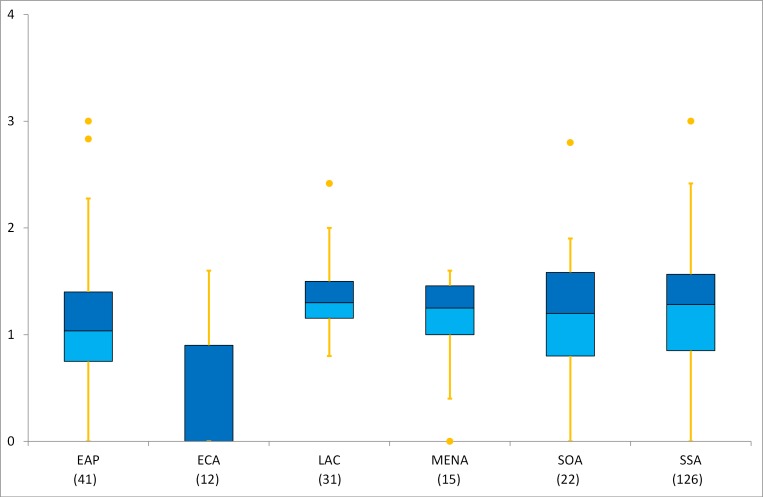
Box plots of W-scores by region.The bottom (light blue) and top (dark blue) of the box represent the 25th and 75th percentiles respectively.